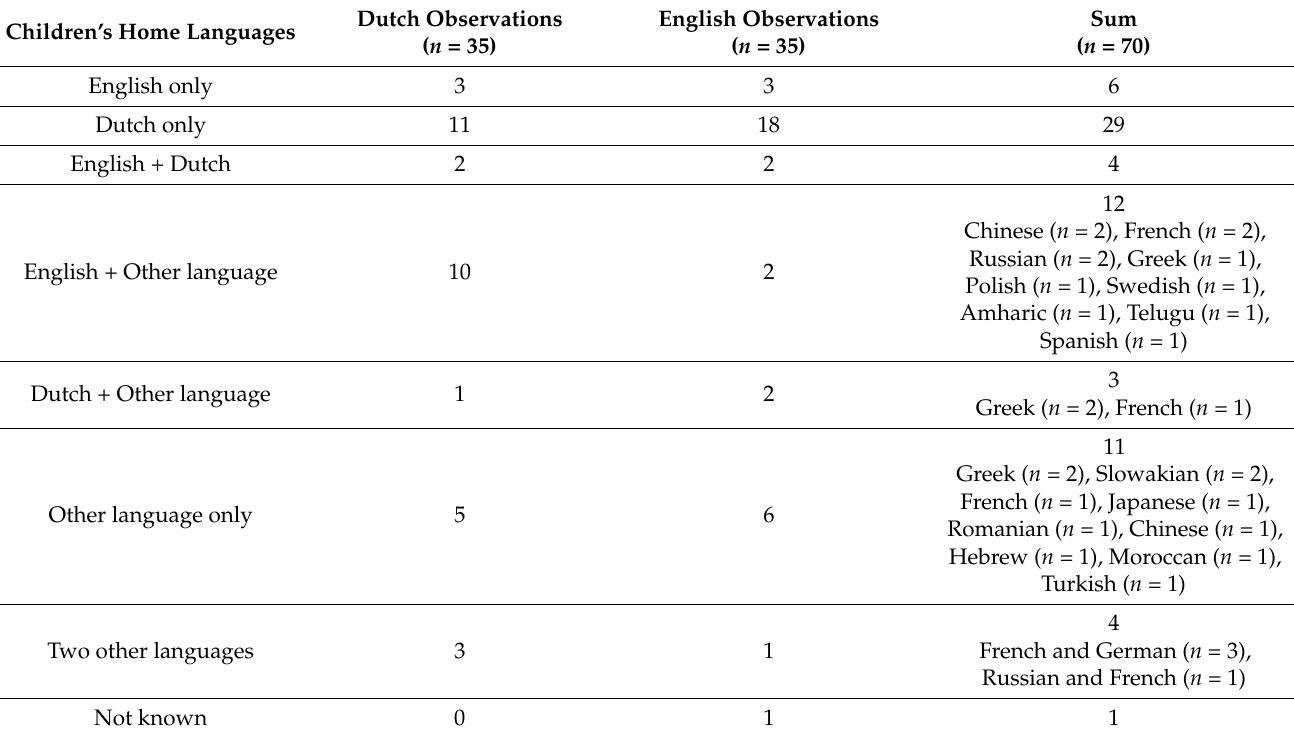
Table 2. Children’s home languages across the Dutch and English